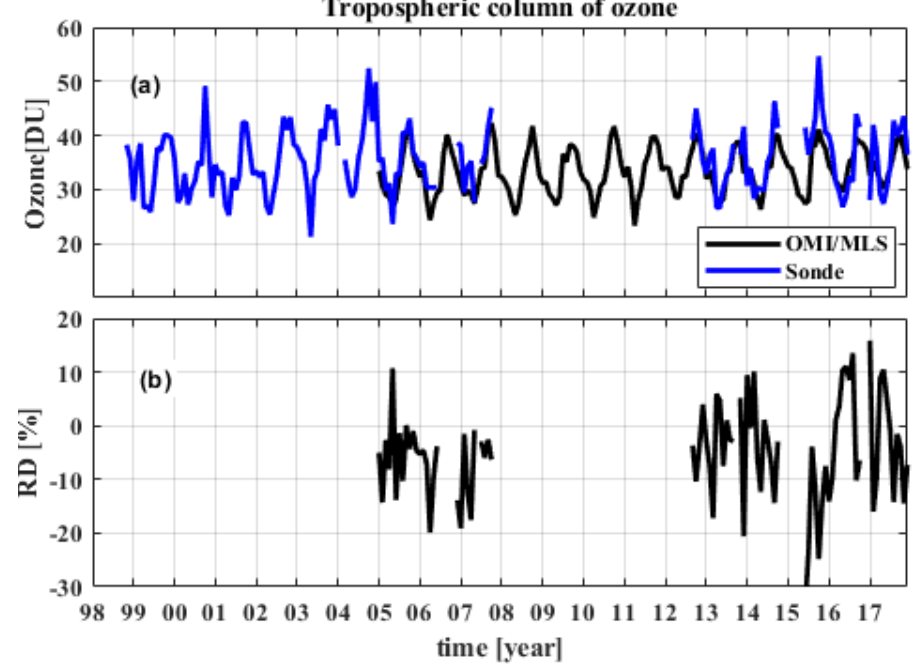
Figure 5. ( a ) The time-evolution of monthly average values of tropospheric partial column of ozone (TPC) recorded from ozonesonde (1998–2007, 2012–2017) (see blue line). OMI/MLS TPC values are shown with a black line (2004–2017) and ( b ) relative difference obtained during the period where radiosonde and satellite measurements are achieved.